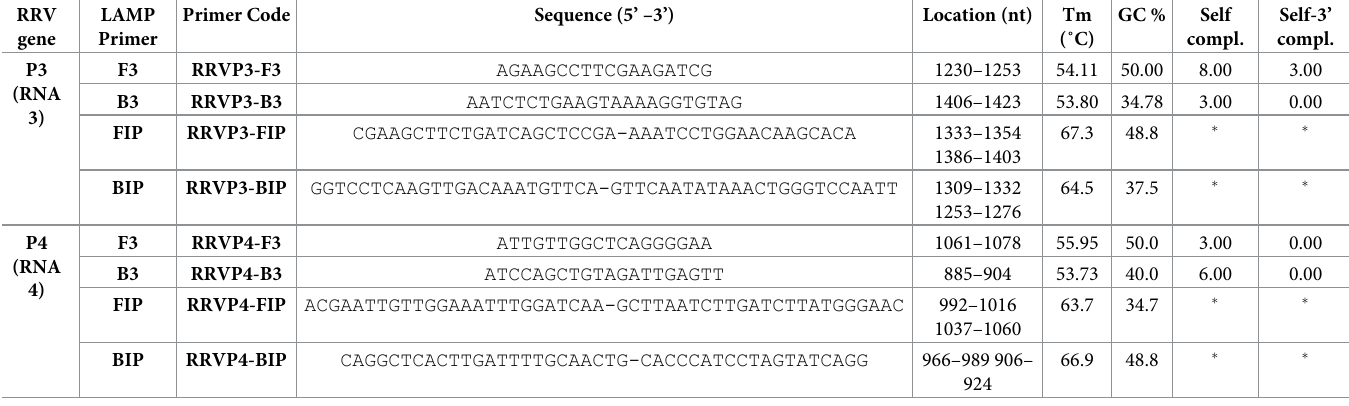
Table 1. General thermodynamic characteristics of the LAMP primers designed for rose rosette virus (RRV) and calculated by primer explorer. RRV LAMP Primer gene Primer